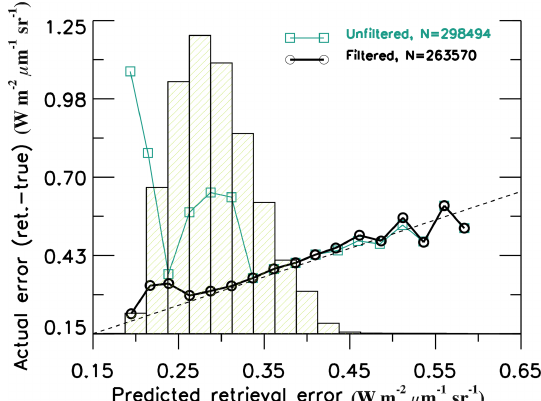
Figure 21. Actual versus predicted IDP SIF error for the unfiltered and filtered annual dataset. This is for the nadir–land retrievals using instrument noise. The histogram shows the filtered data frequency normalized to 1, with the one-to-one relationship given by the dot- ted line.